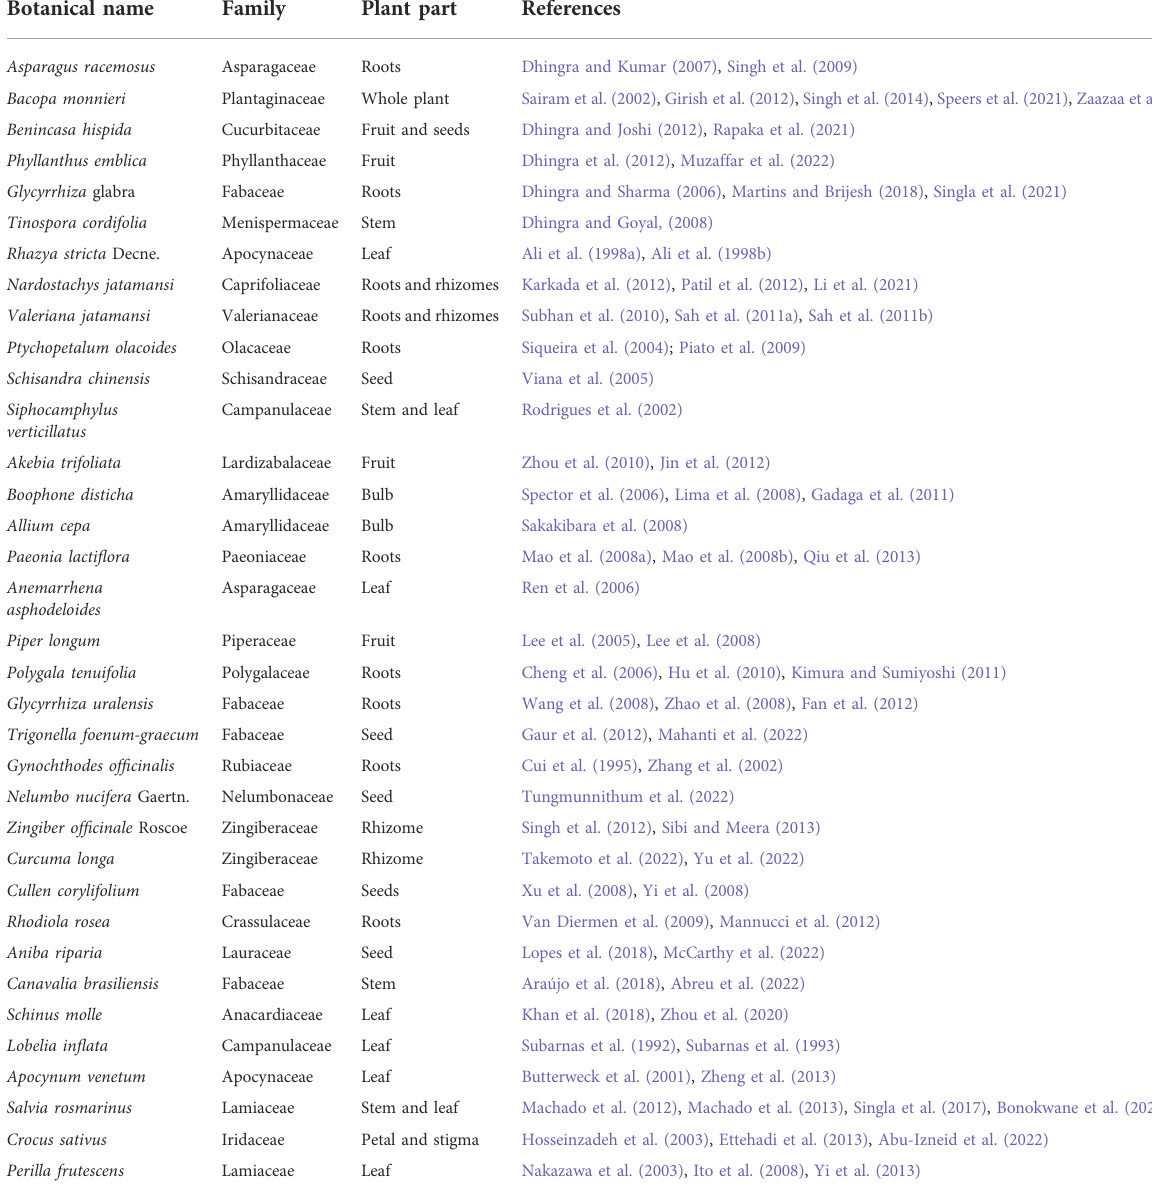
TABLE 2 Different types of plants used for